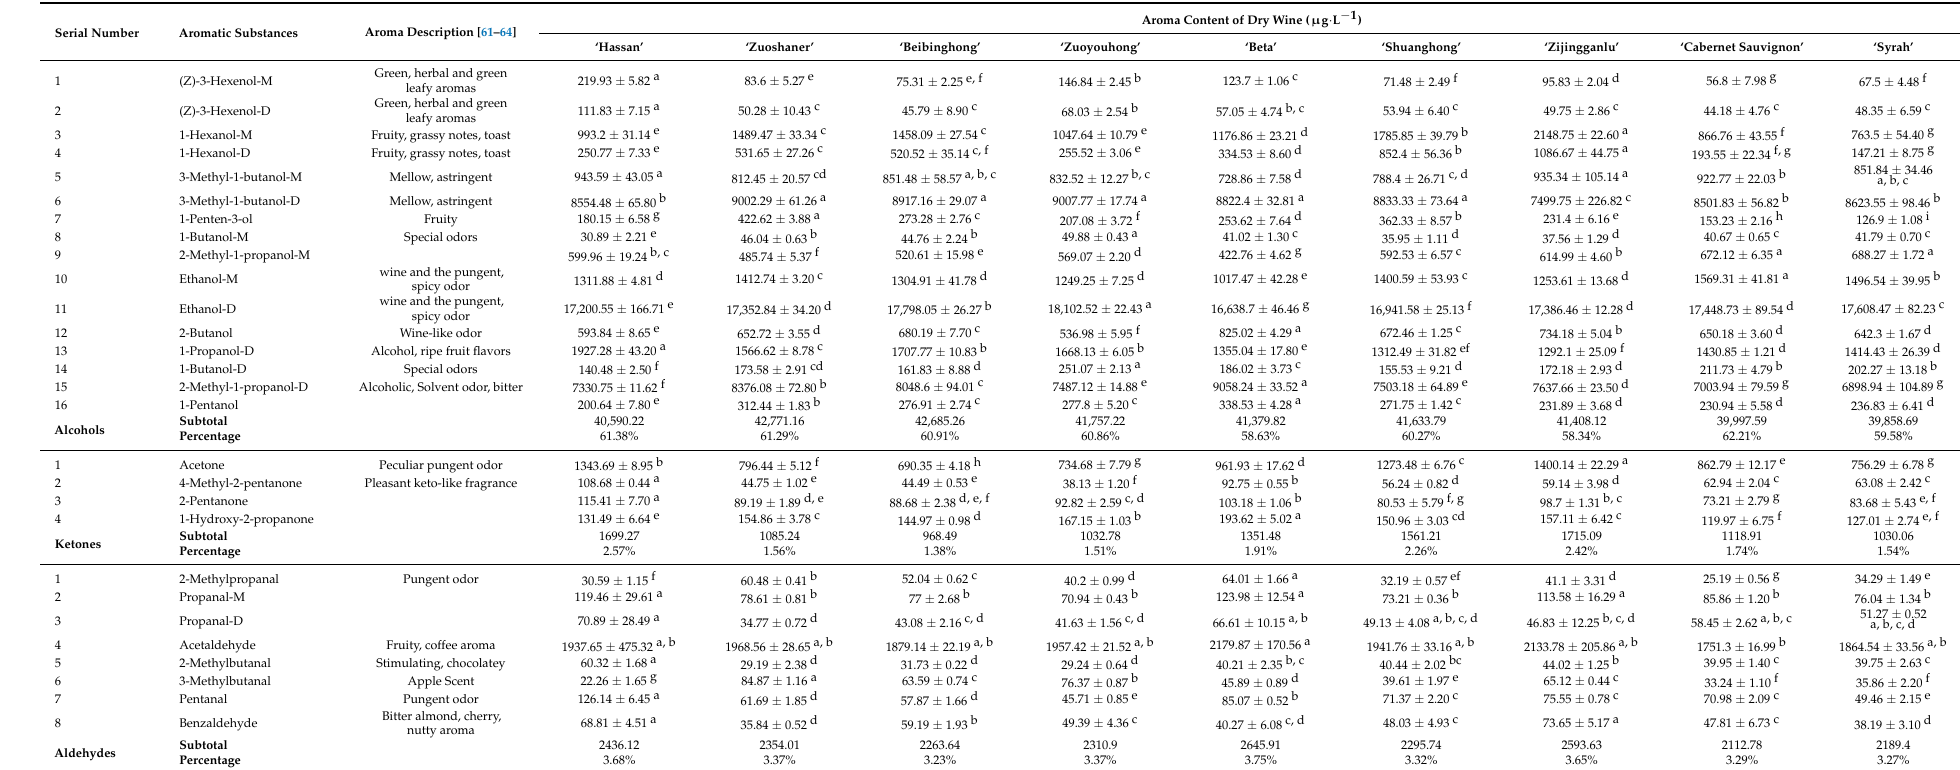
Table 6. Composition of volatile compounds in different varieties of wine